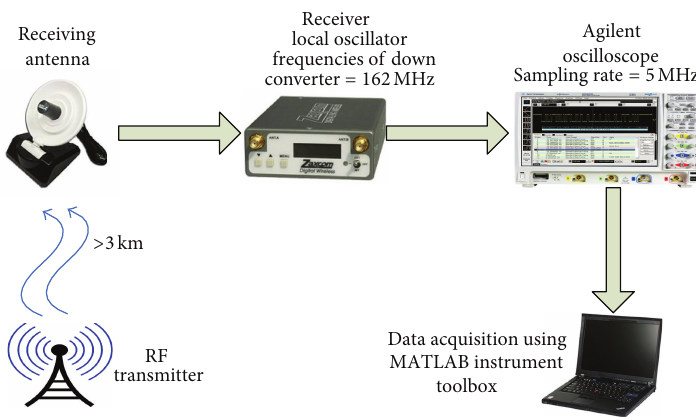
Figure 2: The block diagram of the signal acquisition for wireless